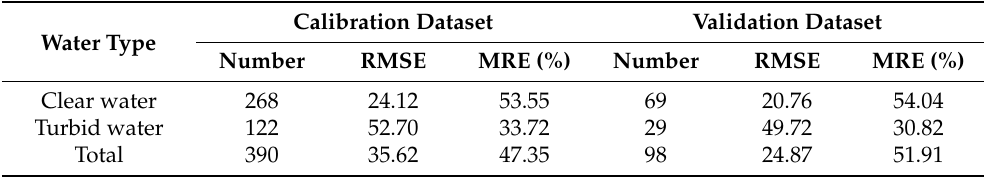
Figure 7. Scatterplots showing the derivation of the accuracy of Sentinel-2 derived SSC relative to in situ SSC ( n = 488). ( a ) Calibration datasets ( n = 390), ( b ) validation datasets ( n = 98). Table 2. Summary of the statistical attributes and model performance using the calibration and validation